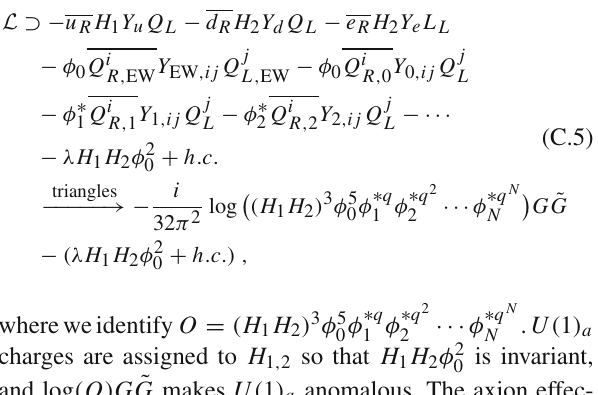
Fig. 7 Range of parameters for a DM ALP of mass m a ≤ 10 − 2 eV (axions suitable to saturate the DM relic density are found in colored regions, all axes are